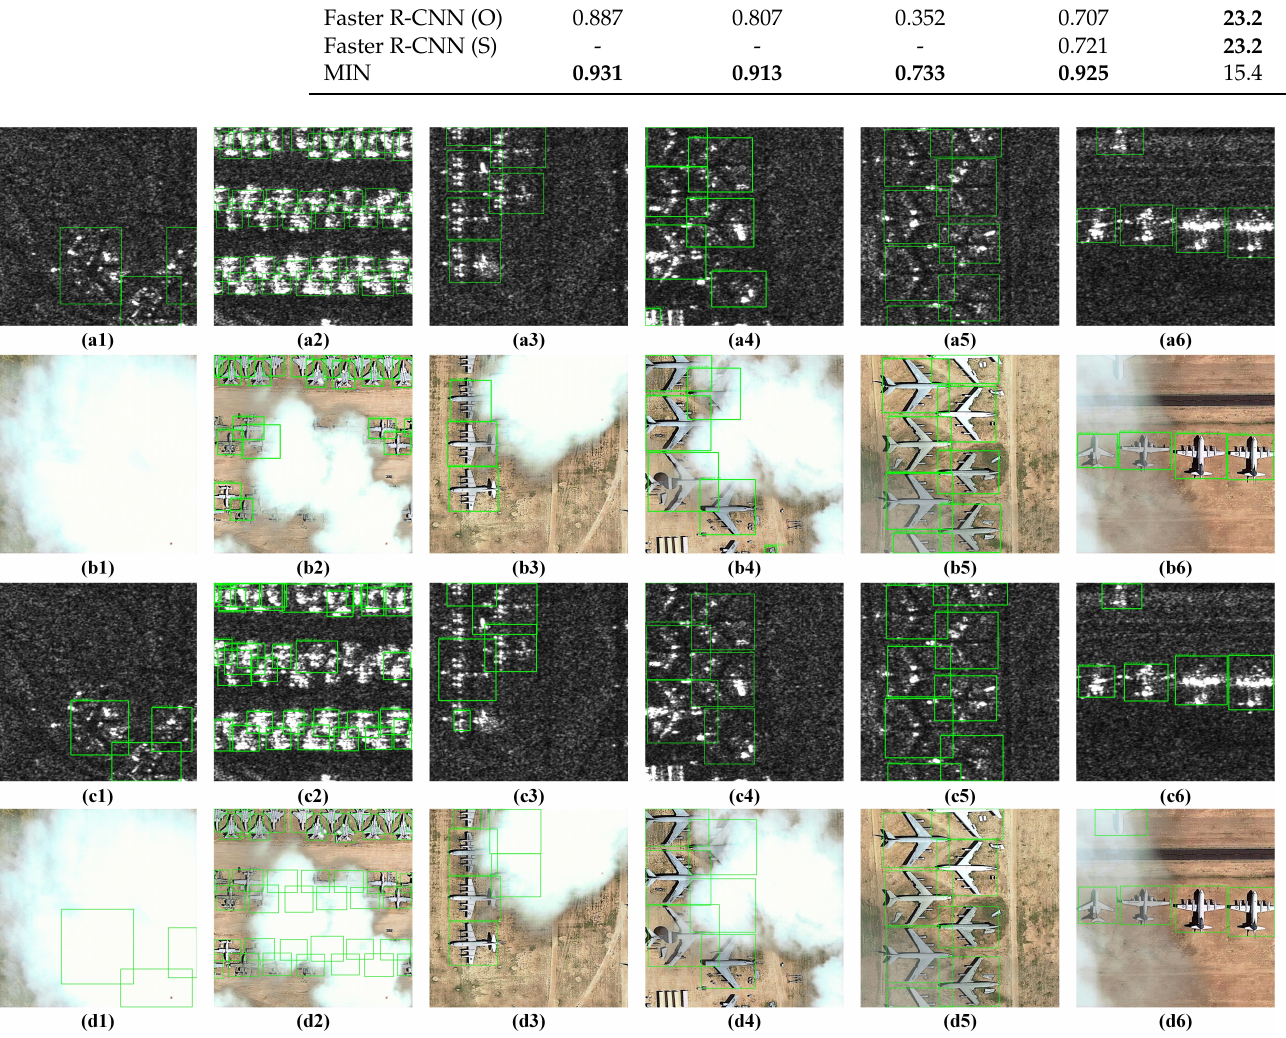
Figure 8. Visual comparison among different sensor image object detection results. ( a1 – a6 )